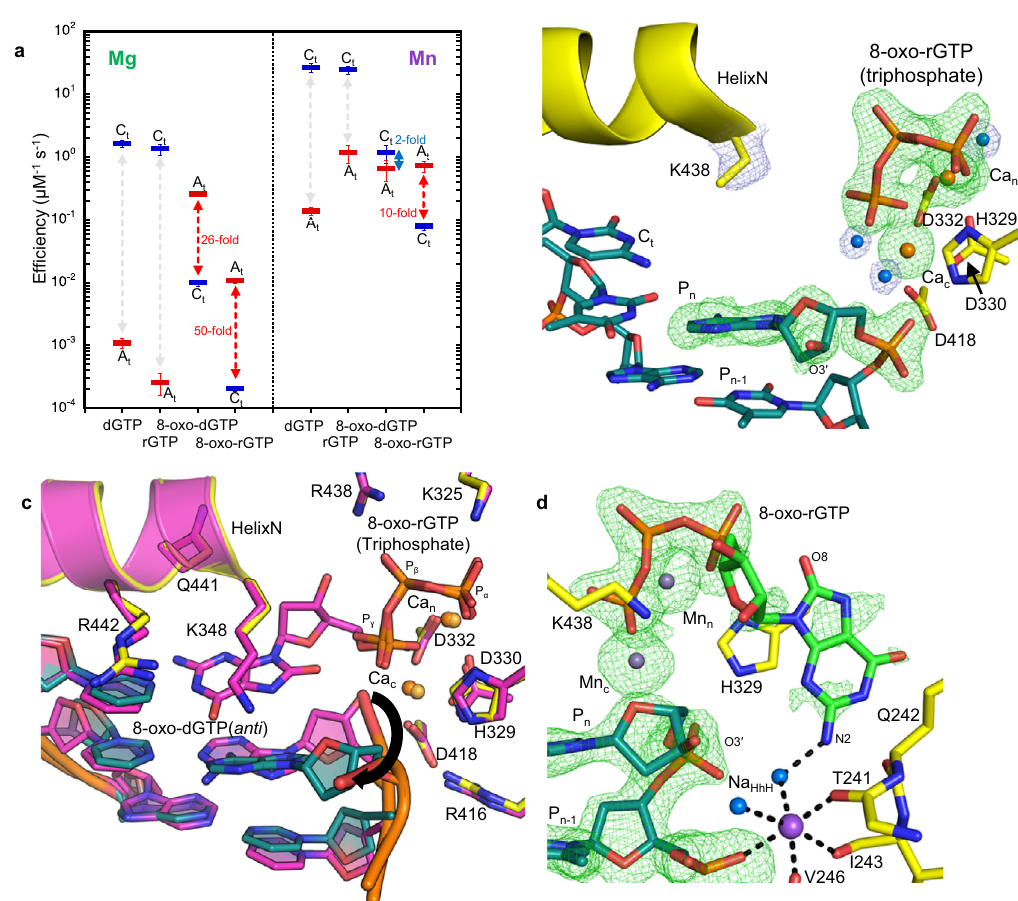
Fig. 2 Structural basis for 8-oxo-rGTP discrimination opposite cytosine. a Kinetic analysis of oxidized and undamaged (d)GTP insertion by pol μ . Catalytic ef fi ciency is indicated as a blue line for insertion opposite template base C (C t ) and as a red line for insertion opposite template base A (A t ), in the presence of Mg 2 + (left panel) or Mn 2 + (right panel). Fold preference is indicated next to a blue (C t ) or red (A t ) dashed arrow. The error bars represent standard errors (S.E.) derived from three independent measurements. b Active site of the Ca 2 + -bound precatalytic ground state 8-oxo-rGTP:C t ternary complex. Protein sidechains are shown in yellow stick representation and DNA is in cyan, Helix N is shown as a yellow cartoon. Ca 2 + atoms are the orange spheres, waters are blue spheres. Simulated annealing (F o – F c ) omit density (green mesh) shown is contoured at 3 σ . The σ A (2F o – F c ) map shown as a blue mesh is contoured at 1.5 σ with a carve radius of 1.0 Å. c Comparison of Ca 2 + -bound precatalytic ground state deoxy- (purple sidechains and DNA) and ribo-8-oxo-GTP:C t (yellow sidechains and cyan DNA) ternary complexes. Rotation of the primer terminus (P n ) in the 8-oxo-rGTP structure is shown with a blackarrow, placing O3´ in an inverted orientation that is incompatible with attack at P α . d Mn 2 + -ground state 8-oxo-rGTP:C t ternary complex (15 min soak) showing 8-oxo-rGTP in an unreactive orientation. Mn 2 + atoms are the small purple spheres, Na + is shown as a larger purple